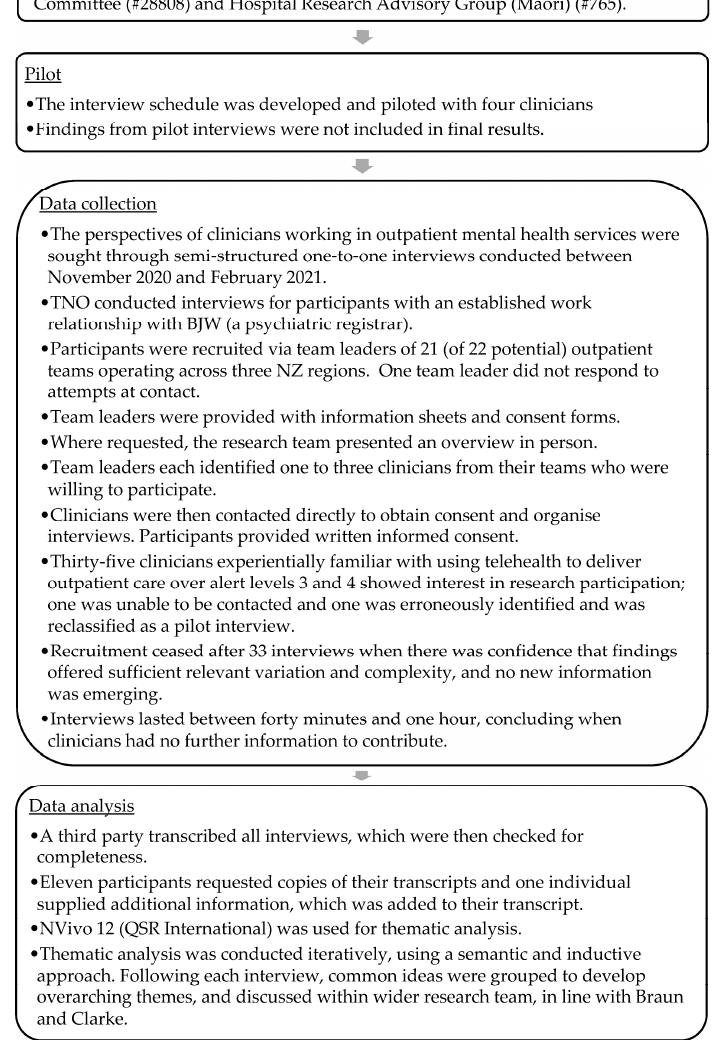
Figure 1. Data collection and analysis.